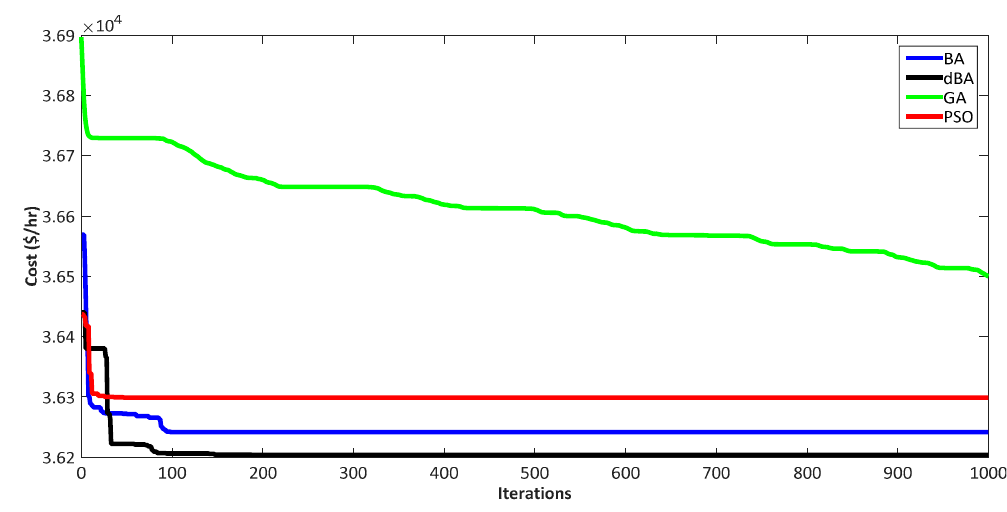
Figure 18. Convergence graphs for 3000 MW demand without renewables.